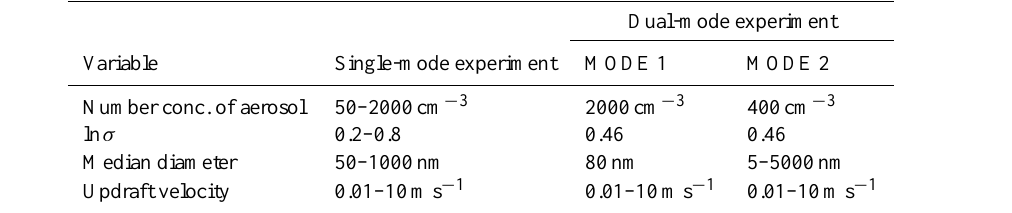
Table 2. Parameter space investigated for both ACPIM and the parameterisations. Two evaluations were done: single mode and dual mode experiments.